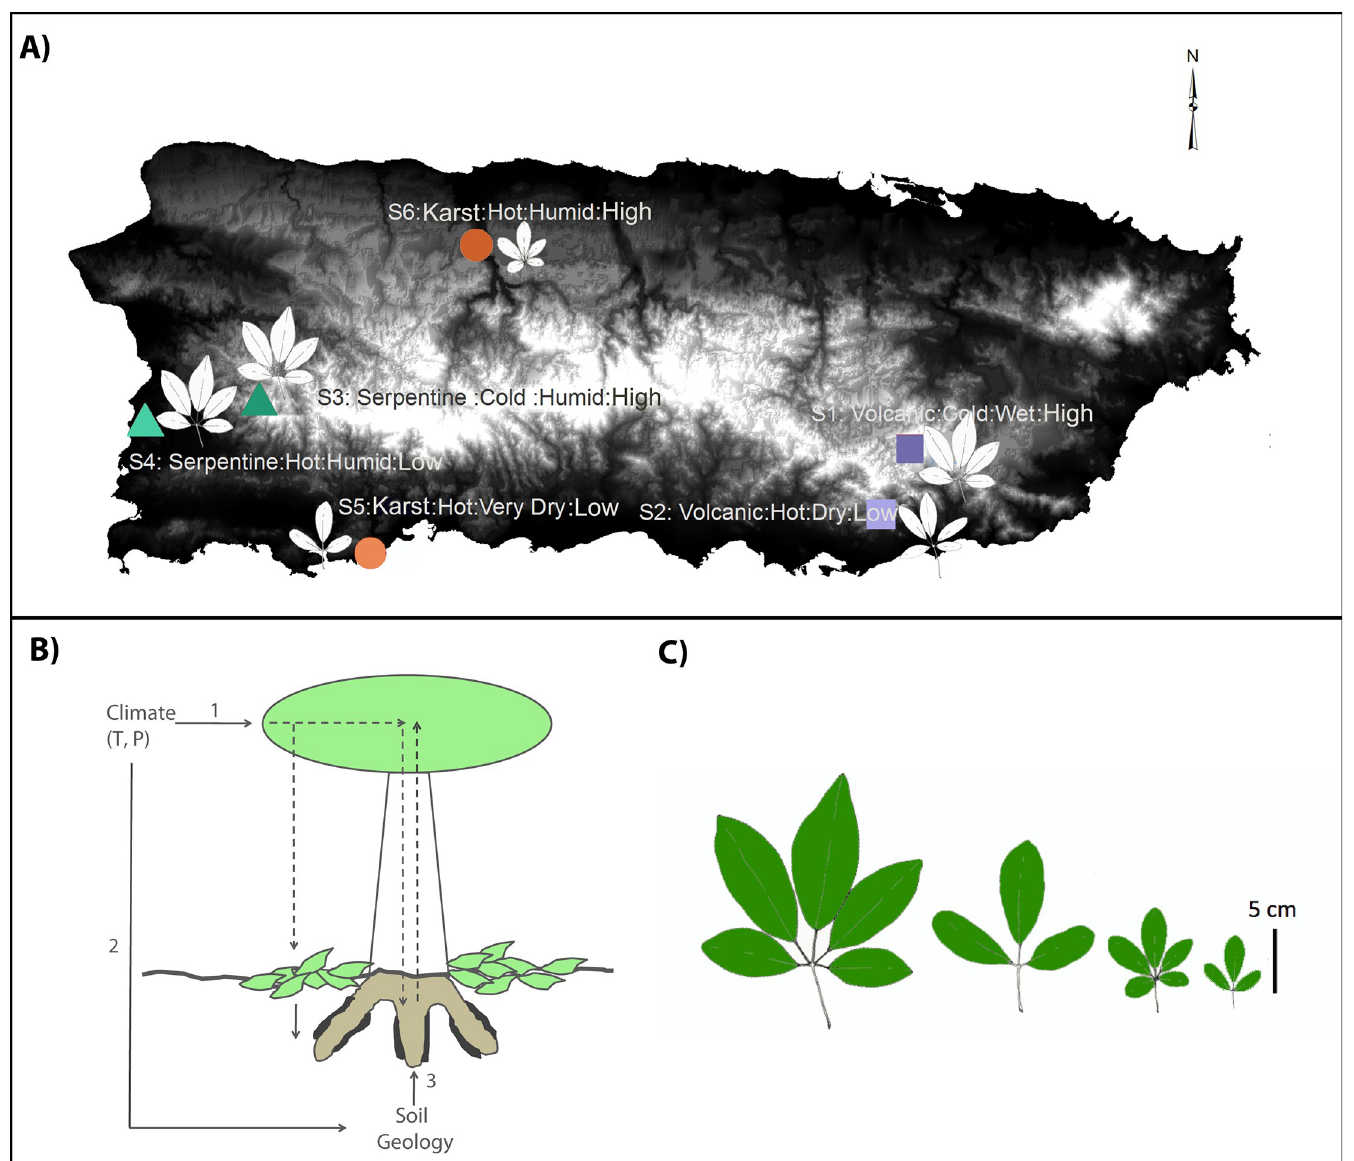
Fig 1. Map of the Island of Puerto Rico with the locations, parental material, temperature, humidity and elevation, and leaf morphology respectively, of each site. GPS coordinates are in Table 1. https://doi.org/10.1371/journal.pone.0231083.g001 high altitude Bosque Estatal de Maricao 18˚ 09’ 33.4’’ N 66˚ 59’ 55.5’’ W; and Site 4 (S4) was in Cabo Rojo, low altitude (near sea level), 18˚ 07’ 51.1" N 67˚ 09’ 34.4" W. Limestone/karst areas (in this work, karst) were located in Bosque Estatal de Gua´nica (low altitude karst) 17˚58 0 18 @ N 66˚54 0 29 @ W and in high altitude area, Arecibo (S6), 18˚ 22’ 49.1’’ N 66˚ 41’ 09.6’’ W. Thus, each site represents a unique combination of parent material and climate (Table 1). A map rep- resenting the collection sites, was prepared using the SRTM–Shuttle Radar Topography Mis- sion Digital Elevation Data (90 m). At each site, three T . heterophylla trees (each tree represents a sampling unit) were chosen based on similar sizes, to sample the rhizosphere and nearby bulk soil. Once the tree was identified, the soil was dug nearby to identify the main root